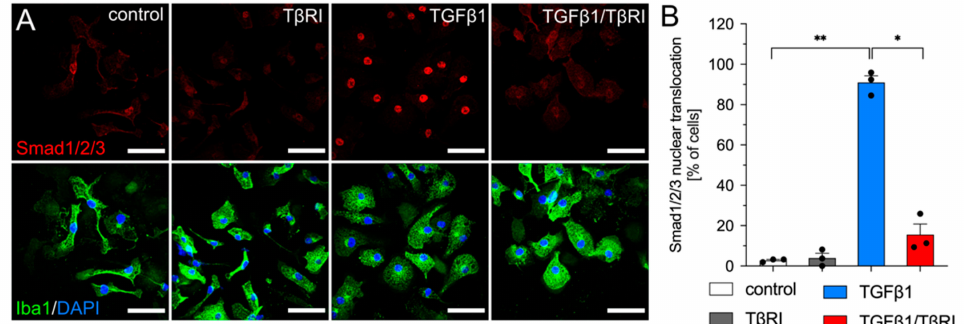
Figure 3. T β RI efficiently blocks TGF β 1-induced SMAD nuclear translocation in primary microglia. Primary microglia were treated with T β RI (500 nM), TGF β 1 (5 ng/mL), or a combination of both reagents for 2 h under serum-free conditions. ( A ) Representative immunocytochemistry images after staining with anti-Iba1 and anti-SMAD1/2/3 primary antibodies and fluorescence-coupled secondary antibodies. DAPI was used to counterstain nuclei. ( B ) Quantifications of microglia with nuclear SMAD accumulation. Scale bars indicate 50 µ m. Data are given as means ± SEM for three independent experiments. p -values derived from one-way ANOVA followed by Tukey’s multiple comparison tests are shown as follows: * p < 0.05 and ** p < 0.01.